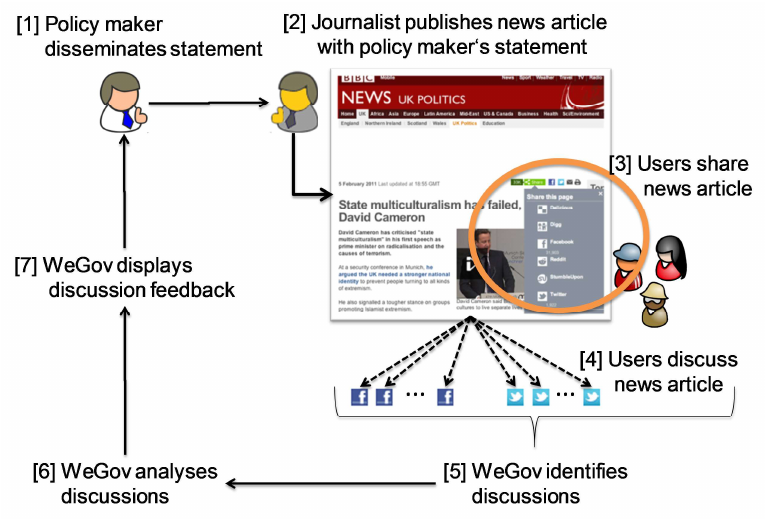
Figure 1: The Newspaper